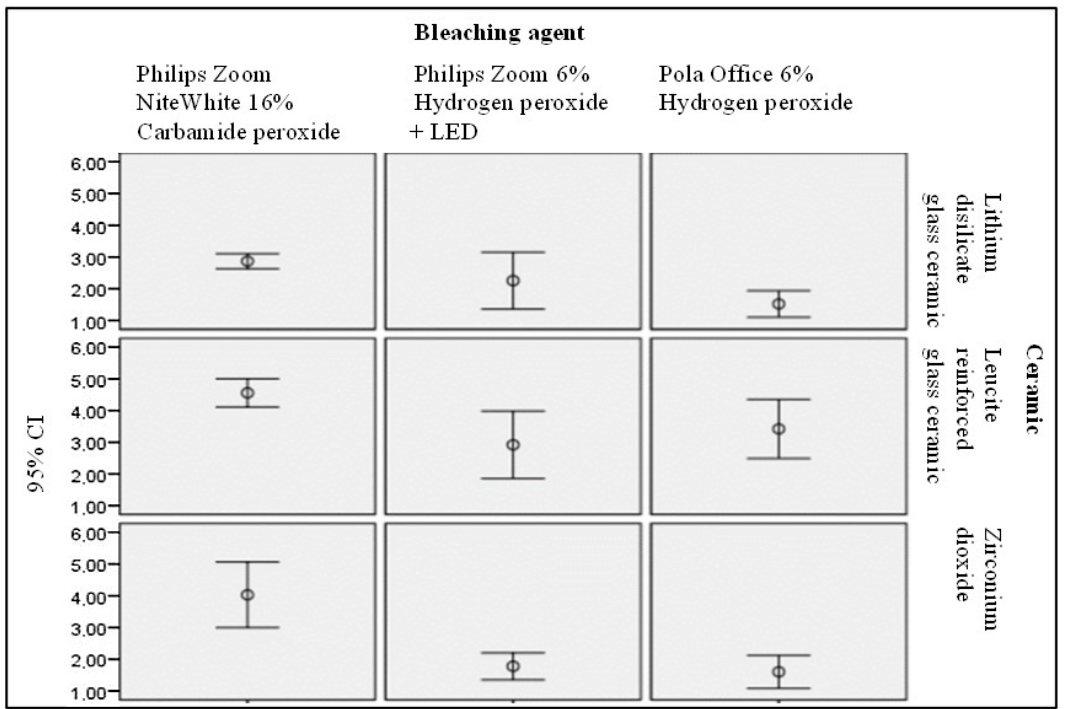
Figure 3. Statistical evaluation of the bleaching agent impact on the polished surface colour alterations of the treated ceramic samples.